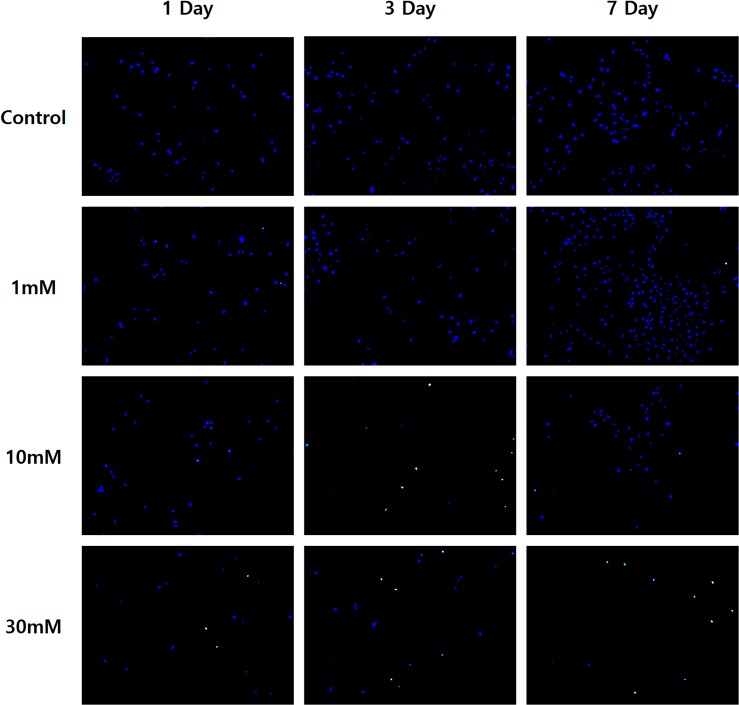
Fluorescence microscope images of nuclear counterstains with Hoechst staining and TUNEL assay.Proliferation (blue color) and apoptosis (small green spots) of MG-63 cell samples cultured with 0, 1, 10 and 30 mM of TSP for 1, 3 and 4 days were illustrated.